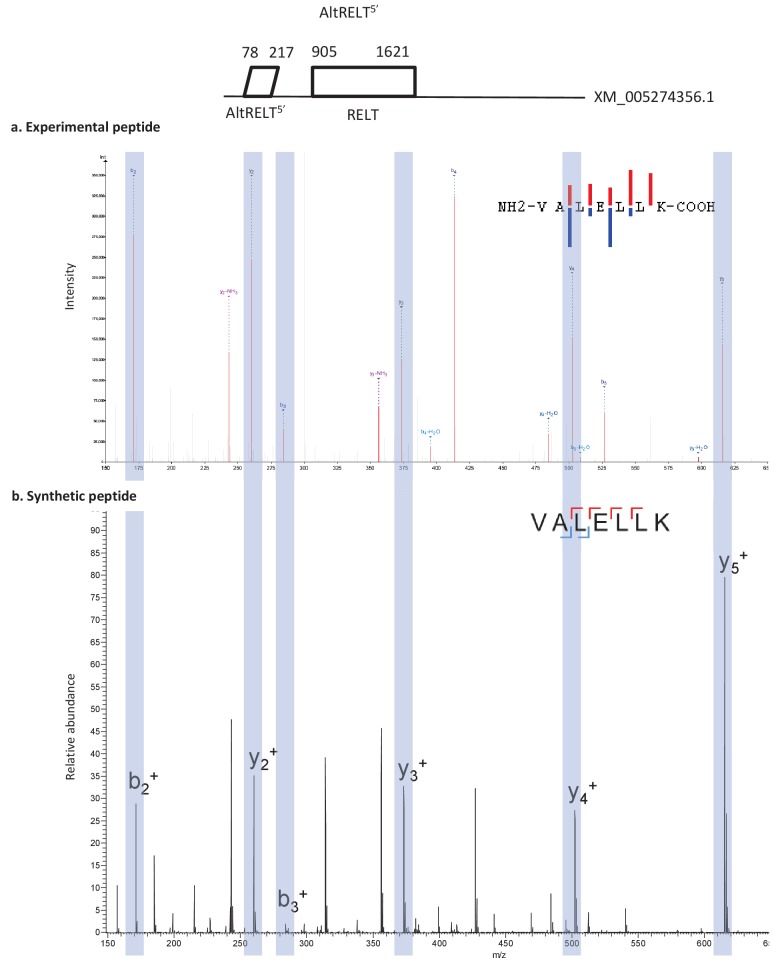
Spectra validation for altRELT5’.Example of validation for altRELT5’-specific peptide VALELLK. (a) Experimental MS/MS spectra (PeptideShaker graphic interface output). (b) MS/MS spectra of the synthetic peptide. Matching peaks are shown with blue masks. A diagram of the transcript with its accession number and the localization of the altORF and the CDS is shown at the top.